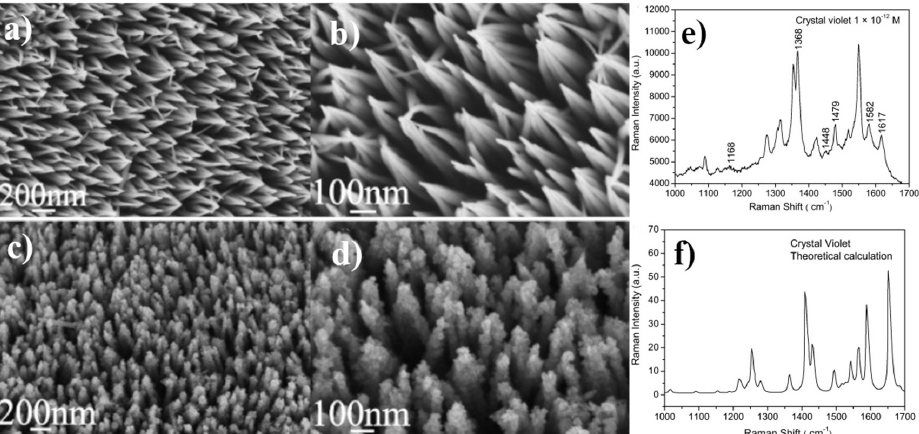
Figure 8. ( a , b ) SEM images of ZnO nanoarrays; ( c , d ) SEM images of ZnO/Ag composite nanoarrays, ( e ) SERS spectrum of crystal violet adsorbed on ZnO/Ag composite nanoarrays from 10 − 12 M crystal violet solution, ( f ) theoretically calculated Raman spectrum of crystal violet. Reprinted with permission from [41]. Copyright 2011 Elsevier.